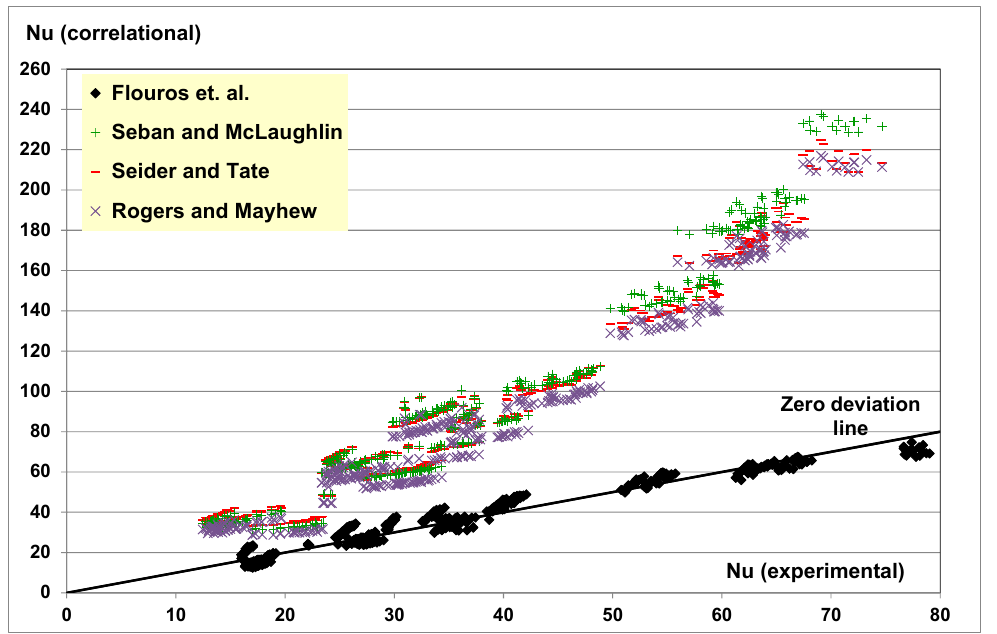
Figure 12. Comparison of Nusselt number correlations to the test results (second set).